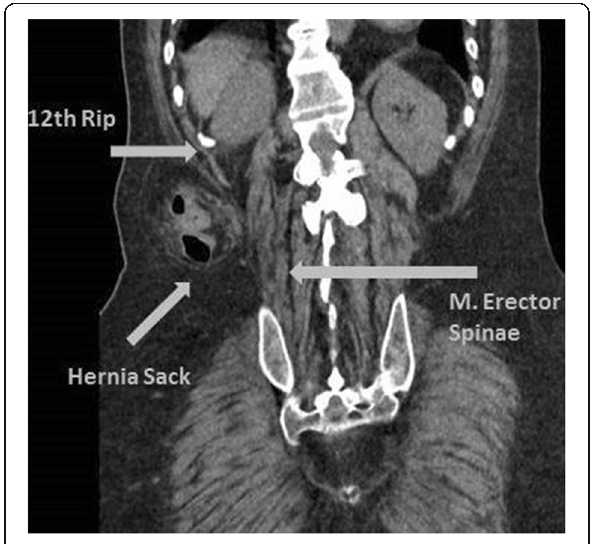
Fig. 2 The hernia sack prolapsed in the superior lumbar triangle between the M. Erector Spinae, the internal oblique and the 12th rip